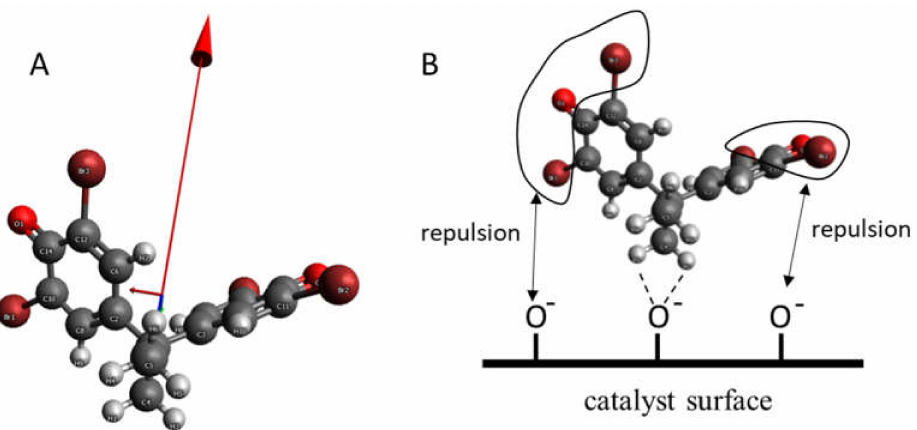
Figure 6. ( A ) Dipole moment direction in compound III (direction of the moment is marked with the arrow); ( B ) catalyst/TBBPA interactions under reaction conditions.